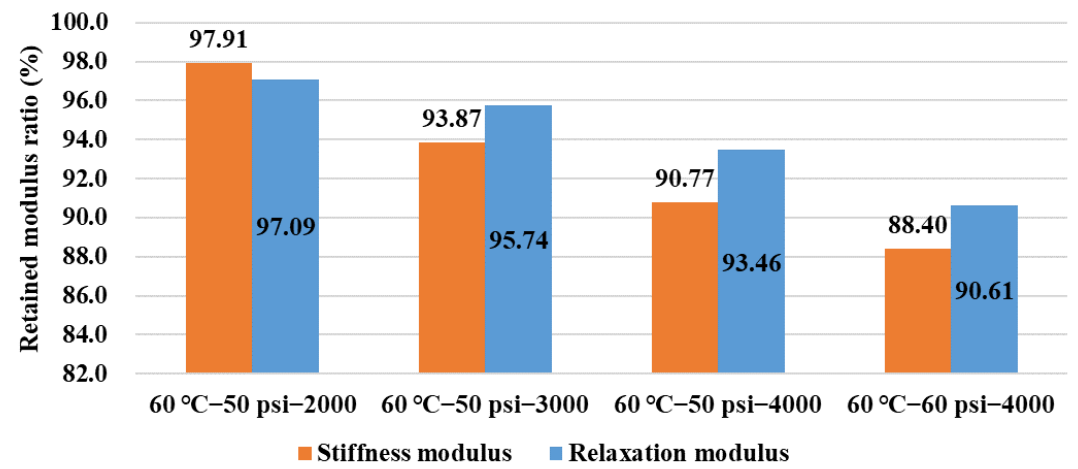
Figure 11. Variation of stiffness modulus and relaxation modulus in BBR tests.